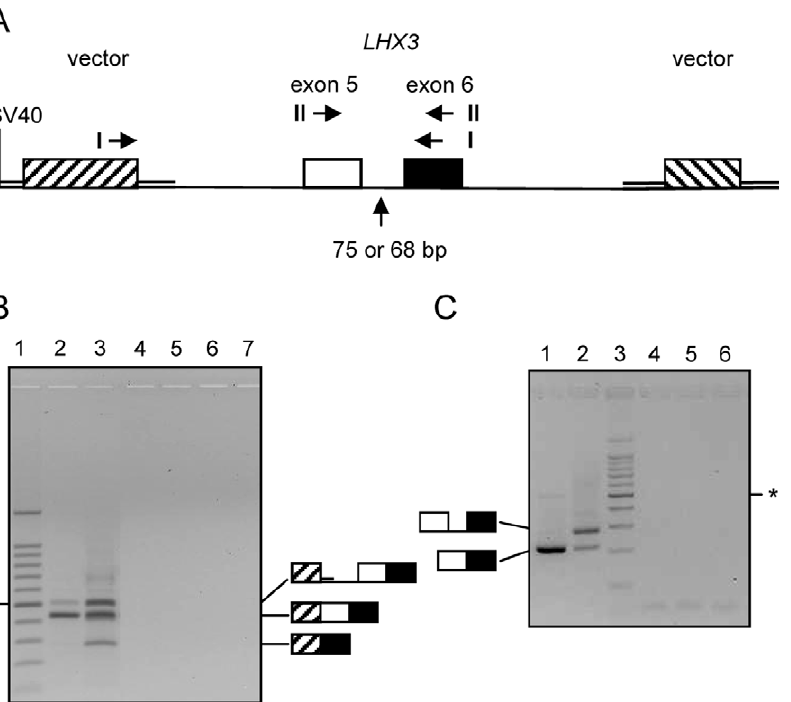
Figure 3. Defective splicing due to a deletion in intron 5 of canine LHX3 demonstrated by exon trapping. (A) Map of part of the plasmids used for transfection of COS-7 cells. The open and closed boxes represent exons 5 and 6 of canine LHX3 , as indicated. The hatched boxes represent chimeric exons that consist of HIV-1 tat and rabbit HBB2 gene sequences. The double lines indicate vector sequences of pSPL3b [50]. The recombinant DNA is transcribed from the SV40 promoter at the indicated position. The map is not drawn to scale. The horizontal arrows indicate the positions of the PCR primer sets I and II that were used on cDNA derived from the cells. Primer set II was adapted to bisulfite treatment of the RNA. The vertical arrow points out intron 5, consisting of 75 bp in the control and 68 bp in the mutant construct. (B,C) Eukaryotic COS-7 cells were transfected with recombinant plasmids containing the control or the mutant intron 5 of canine LHX3 . After 2 days, RNA was isolated and analyzed by RT-PCR. The PCR products were analyzed by agarose gel electrophoresis in the presence of ethidium-bromide. The structure of the fragments was obtained by DNA sequence analysis of bands excised from the gels. These structures are indicated by drawings as in (A). (B) The 7 bp deletion leads to exon 5 skipping in a proportion of the transcripts. The products were analyzed with primer set I. Lane 1: size marker=100 bp ladder, * indicates the 500 bp fragment; lane 2: products derived from cells transfected with plasmids containing intron 5 of 75 bp; lane 3: intron 5 of 68 bp; lanes 4 and 5: as lanes 2 and 3, respectively, except that reverse transcriptase was omitted to exclude contamination of RNA substrate with plasmid DNA; lane 6: transfection with vector pSPL3b without insert; lane 7: no transfection. Primer set I does not amplify fragments containing intron 5 due to the high cytosine content of the intron. (C) The 7 bp deletion leads to retention of intron 5 in a proportion of the transcripts. The RNA was treated with bisulfite and analyzed with primer set II. Lanes 1 and 4: products derived from cells transfected with plasmids containing intron 5 of 75 bp; lanes 2 and 5: products derived from cells transfected with plasmids containing intron 5 of 68 bp; lane 6: transfection with vector pSPL3b without insert; lane 3: size marker=100 bp ladder, * indicates the 500 bp fragment. Lanes 4 and 5: omission of reverse transcriptase to exclude contamination of RNA substrate with plasmid